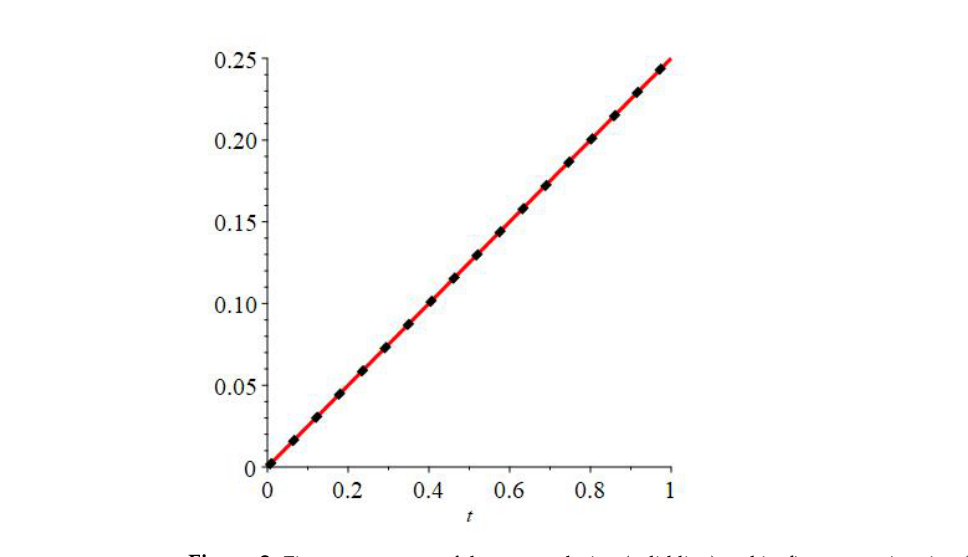
Figure 2. First components of the exact solution (solid line) and its first approximation